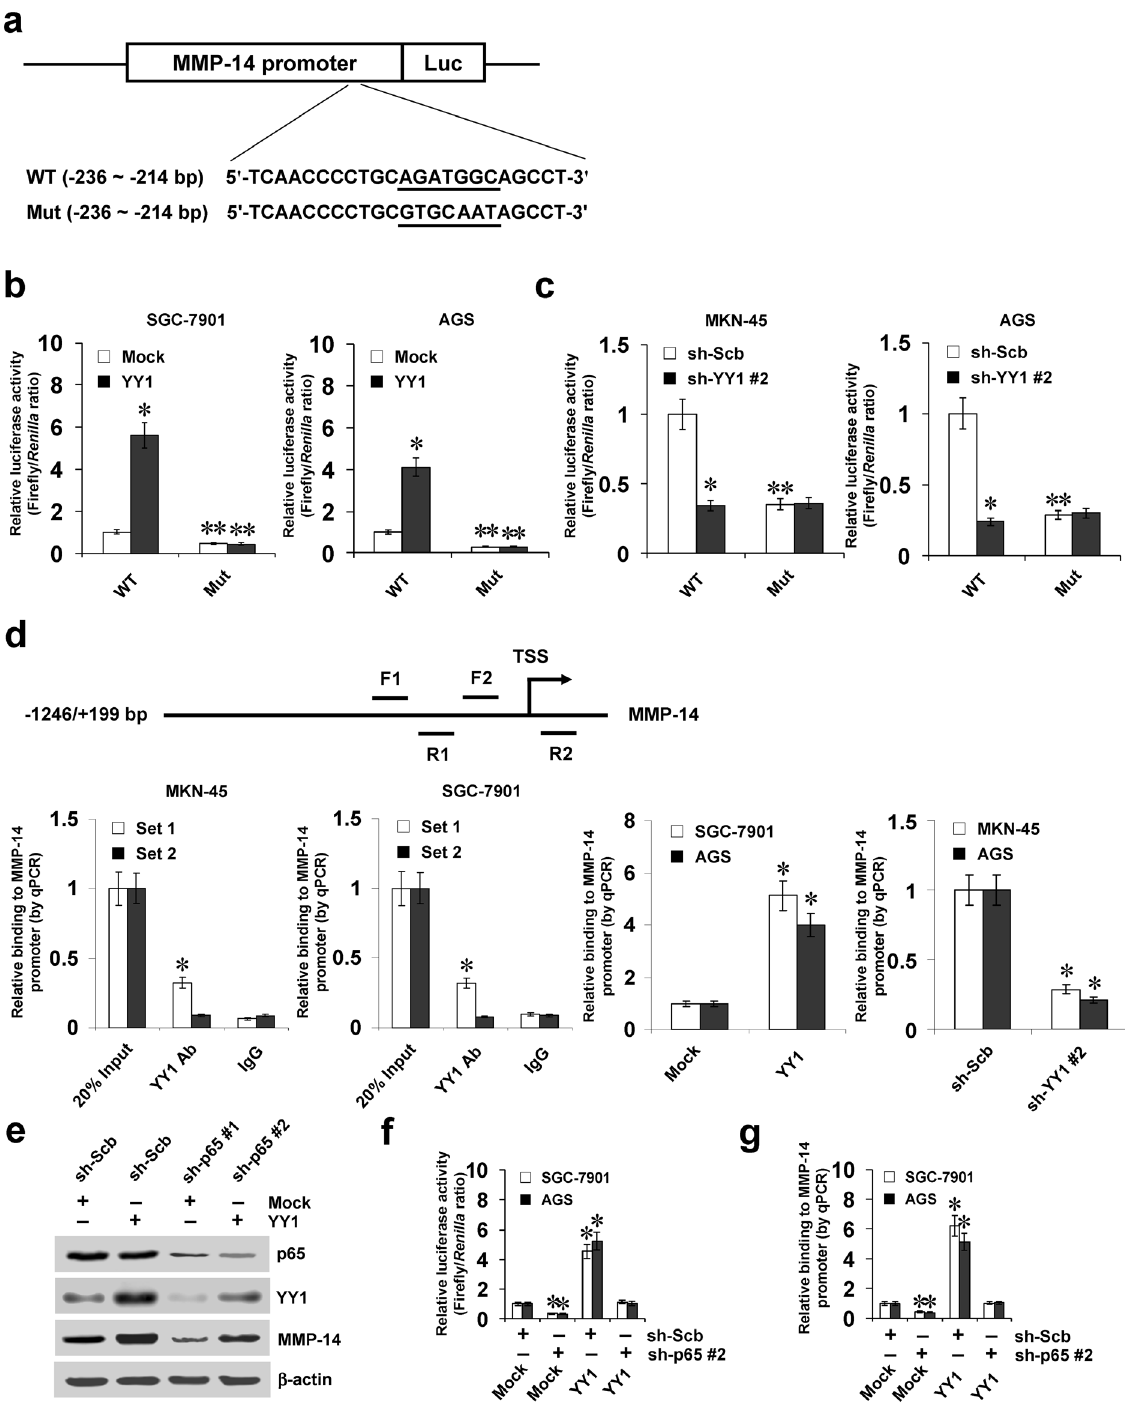
Figure 2. YY1 directly binds to MMP-14 promoter to increase its transcription. ( a ) Scheme and sequence of the intact YY1 binding site (WT) and its mutation (Mut) within the MMP-14 promoter-luciferase reporter vectors. ( b ) Dual-luciferase assay showing the activity (normalized to Mock + WT) of MMP-14 promoter reporter [pGL3-MMP14 (-1246/ + 199)] and its mutant in SGC-7901 and AGS cells stably transfected with empty vector (mock) or YY1 (mean ± SD, n = 5). ( c ) Dual-luciferase assay indicating the activity (normalized to sh- Scb + WT) of MMP-14 promoter reporter [pGL3-MMP14 ( − 1246/ + 199)] and its mutant in MKN-45 and AGS cells stably transfected with scramble shRNA (sh-Scb) or YY1 shRNA (sh-YY1) (mean ± SD, n = 4). ( d ) ChIP (using YY1 antibody) and qPCR assay showing the enrichment of YY1 (normalized to 20% input DNA) on the MMP-14 promoter in gastric cancer cells, and those stably transfected with mock, YY1 , sh-Scb, or sh-YY1 (mean ± SD, n = 5). ( e ) Western blot indicating the expression of p65, YY1, and MMP-14 in SGC-7901 cells transfected with mock or YY1 , and those co-transfected with sh-Scb or sh-p65. ( f and g ) Dual-luciferase,